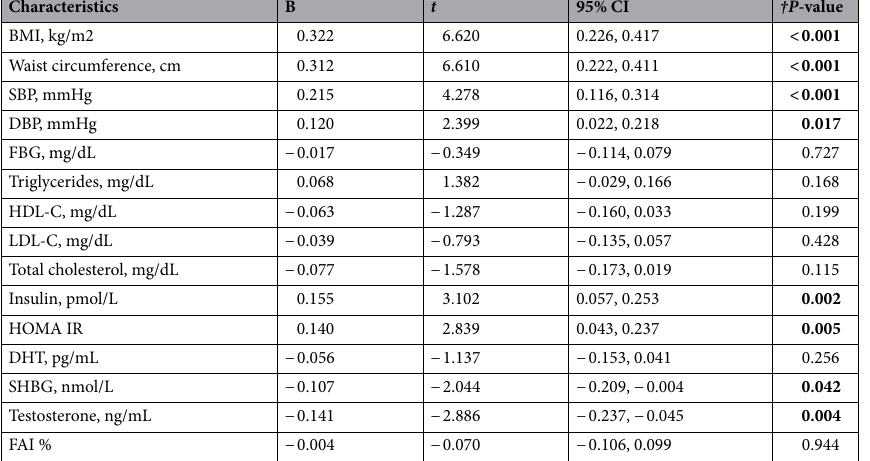
Table 2. Age-adjusted regression analysis of factors that affect PV levels. Bold indicates statistically significant values. CI confidence interval, PV prostate volume, BMI body mass index, SBP systolic blood pressure, DBP diastolic blood pressure, FBG fasting blood glucose, HDL-C high-density lipoprotein cholesterol, LDL-C low- density lipoprotein cholesterol, DHT 5α-dihydrotestosterone, SHBG sex hormone binding globulin, FAI %, free androgen index. † P -value were calculated according to multivariate linear regression analyses after adjustment of age.